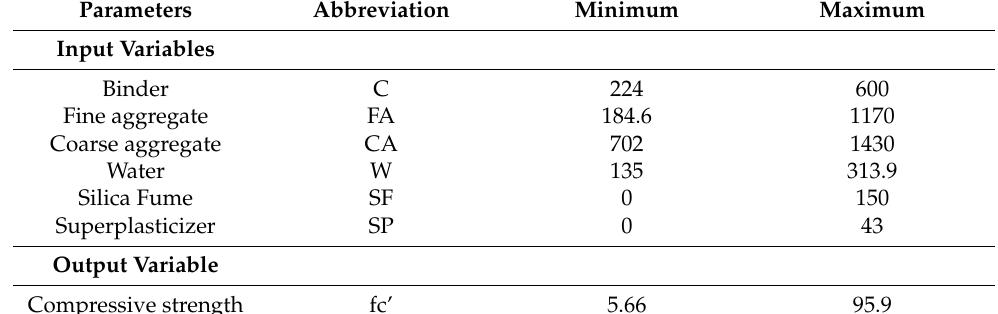
Table 3. The maximum and minimum range of silica fume concrete data for compressive strength.